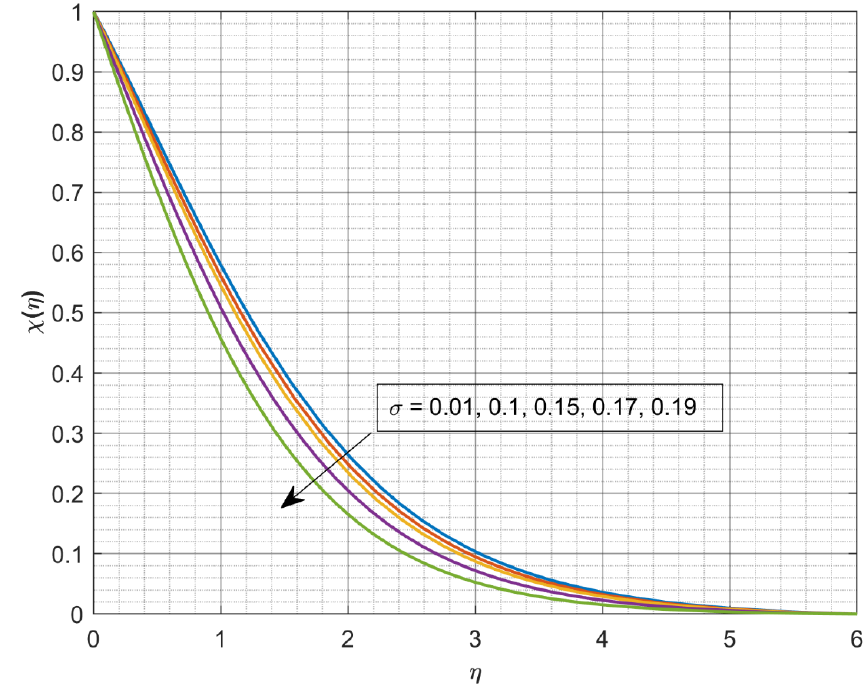
Figure 9. Influence of 𝜎 on 𝜒(𝜂) .